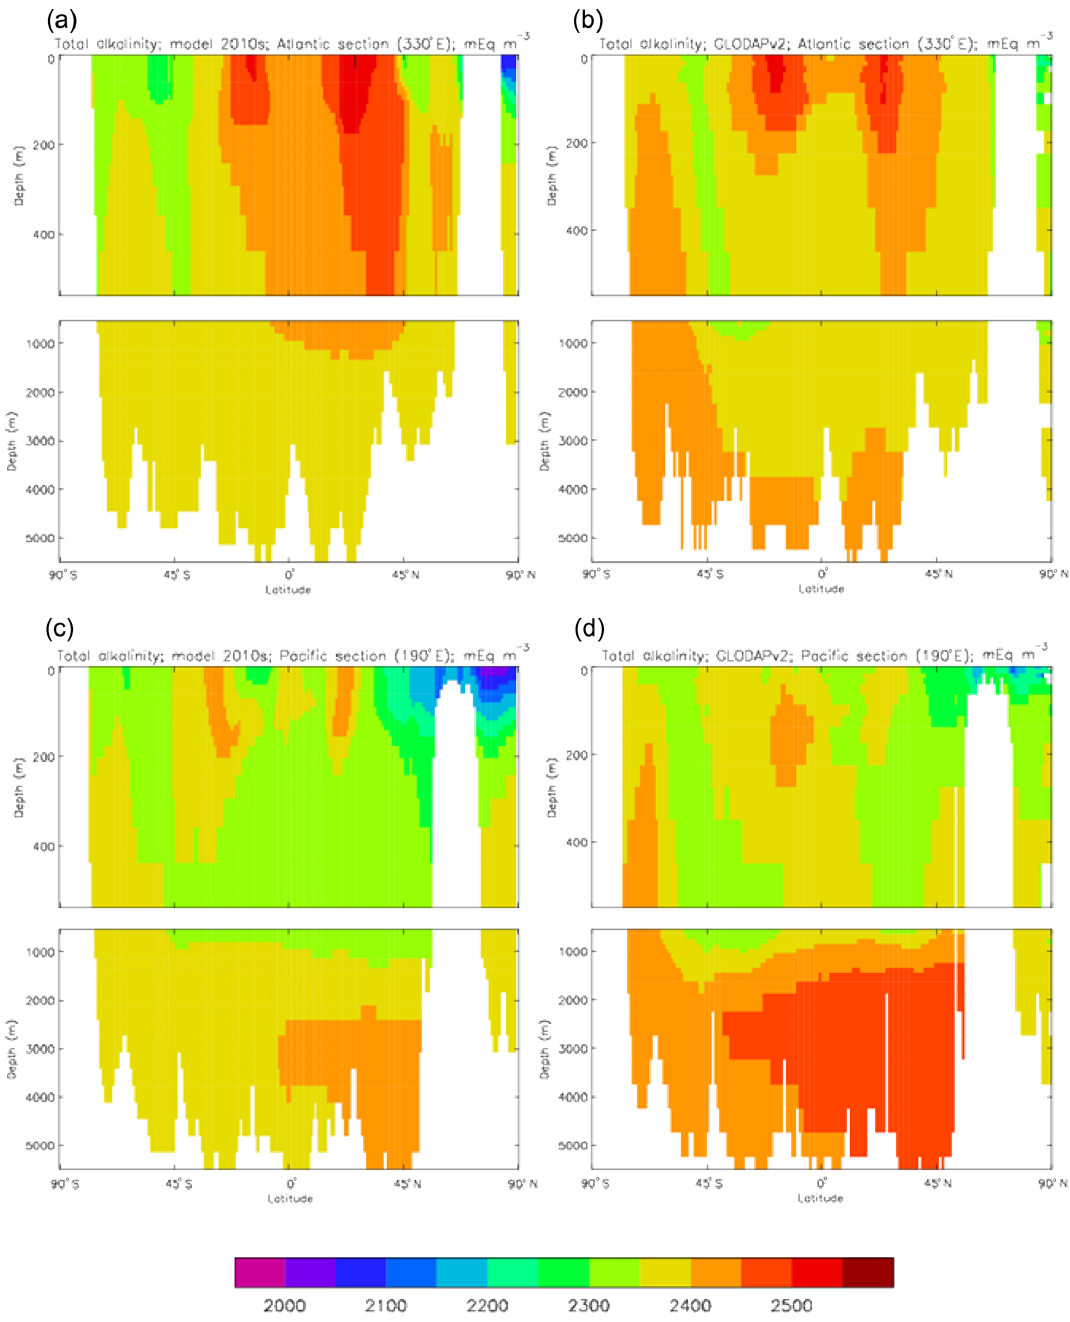
Figure 13. Meridional sections of total alkalinity: panels (a) and (b) show sections in the Atlantic Ocean along 330 ◦ ; (c, d) Pacific Ocean sections along 190 ◦ . Panels (a) and (c) show model concentrations averaged over 2010–2019; panels (b) and (d) show concentrations from the GLODAPv2 gridded